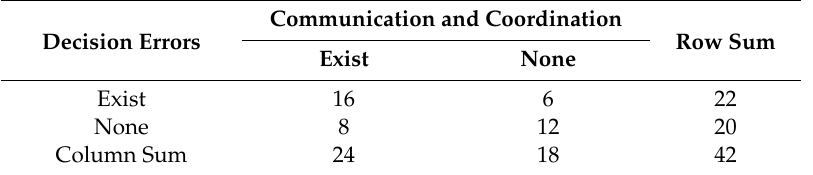
Table 5. Frequency statistics between Communication and Coordination and Decision